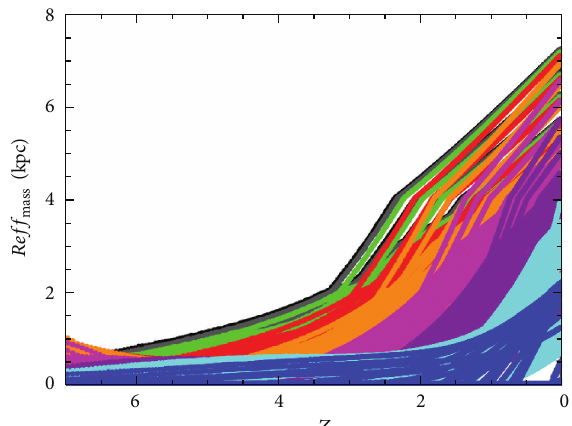
Figure 6: The evolution of the half mass radii, 𝑅𝑒𝑓𝑓 , as a function of the redshift 𝑧 for models with efficiencies sets from 𝑛𝑡 = 1 to 9 and for mass mass distribution numbers from 10 to 44 (see Tables 1 and 2 from MD) corresponding to maximum rotation velocities in the range [80–400] kms −1 . Black, gray, green, red, orange, magenta, purple, cyan, and blue dots correspond to 𝑛𝑡 = 1, 2, 3, 4, 5, 6, 7, 8, and 9, respectively.